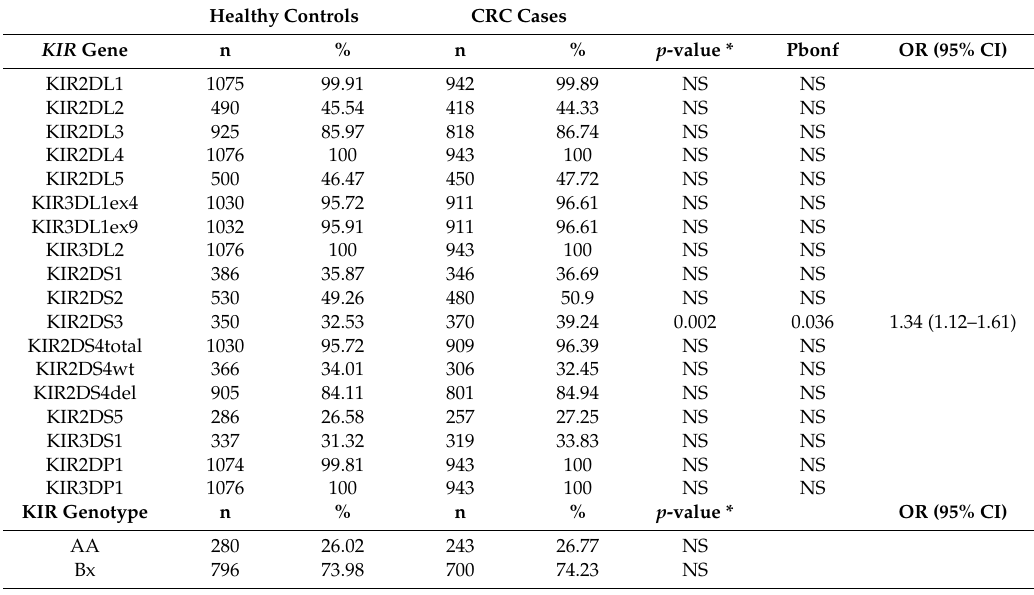
Table 4. KIR gene and genotype frequencies in CRC patients and healthy